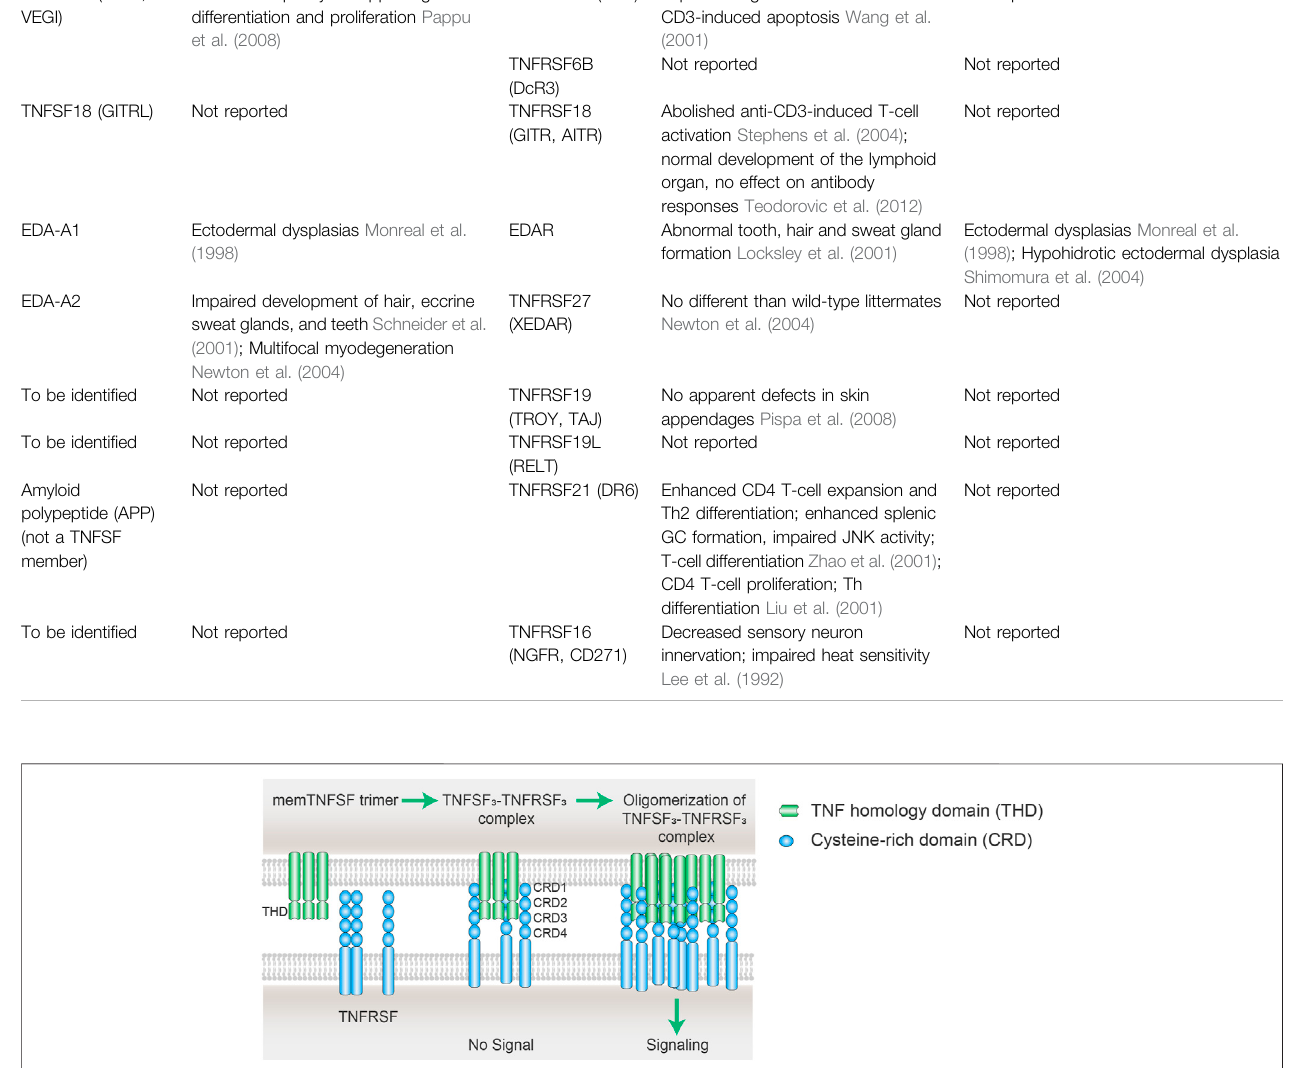
FIGURE2| SchemeofoligomerizationofTNFSF 3 – TNFRSF 3 complexes.ThecellmembraneTNFSF(memTNFSF,oftenassociatedastrimer)bindstoTNFRSF via the interactions between the TNF homology domain (THD) and cysteine rich domain (CRD), resulting in the formation of TNFSF 3 -TNFRSF 3 complex. However, the minimumTNFSF-TNFRSF complexisinsuf fi cient totriggersignaling ofsomeTNFRSFmembersincluding CD40,CD137,OX40, and GITR.Secondaryinteractionofthe initial trimeric complex leads to oligomerization of the ligand-receptor complexes. The clustering of multiple TNFRSFs is necessary to activate receptor intracellular signaling